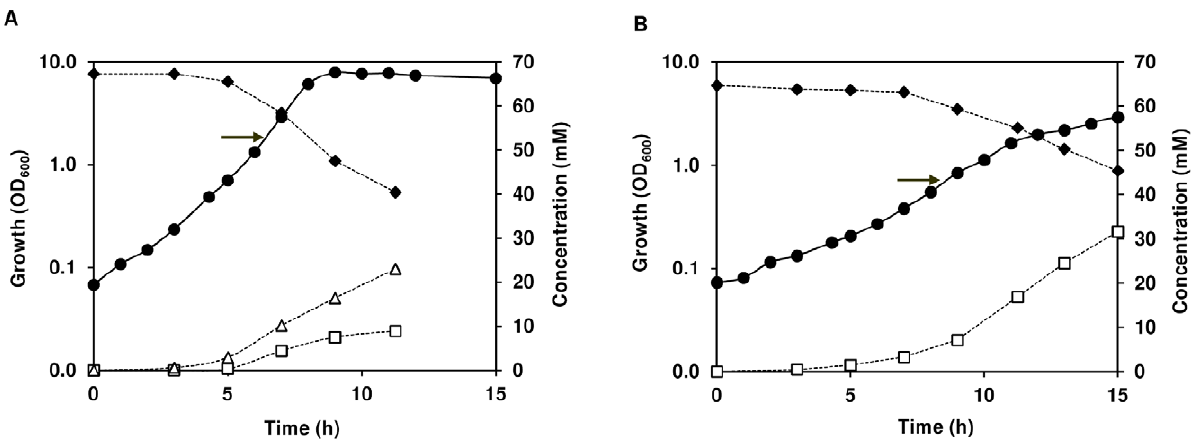
Figure 1. Growth profile of S.aureus COL-S in glucose-CDM. Growth, glucose consumption, and end-product formation by S. aureus COL-S under aerobic (A) and anaerobic (B) conditions. Symbols: (black diamond), glucose; (open square), lactate; (open triangle), acetate; (black circle), biomass. At the time indicated by the arrow a culture sample was withdrawn for in vivo NMR analysis. Data from a representative experiment where the error in each point # 10%. doi:10.1371/journal.pone.0058277.g001 intracellular and extracellular pools of lactate reached their 0.04 m mol min 2 1 mg 2 1 of protein), the intracellular lactate pool suffered a sharp linear decrease (consumption rate 2.5 m mol min 2 1 mg 2 1 of protein) from about 120 to 20 mM, followed by non-linearly in a slow fashion (maximal consumption rate below slow depletion. These profiles might indicate a bottleneck at the